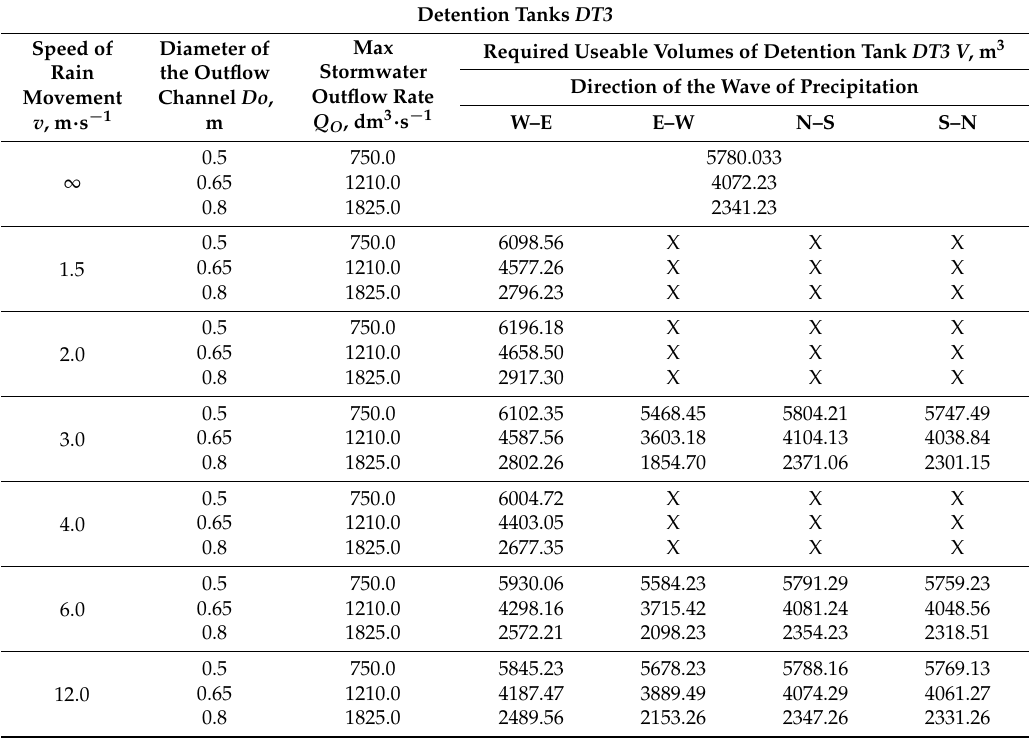
Table 5. Required volumes of detention tanks DT3 determined at the specific diameter of the outflow channels from reservoirs DT1 and DT2 , D O = 0.7